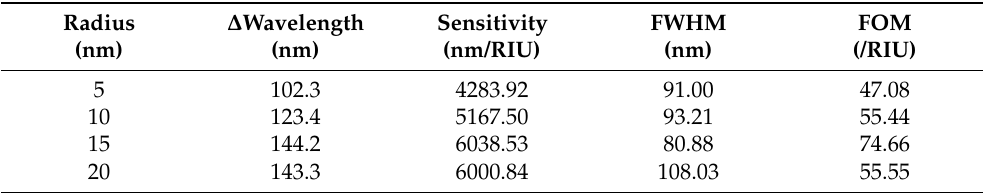
Table 3. Sensitivity, FWHM, and FOM data for different radiuses of TiO 2 nanorods of TiO 2 (film)-Au- TiO 2 (nanorods) triple structure SPR sensor.